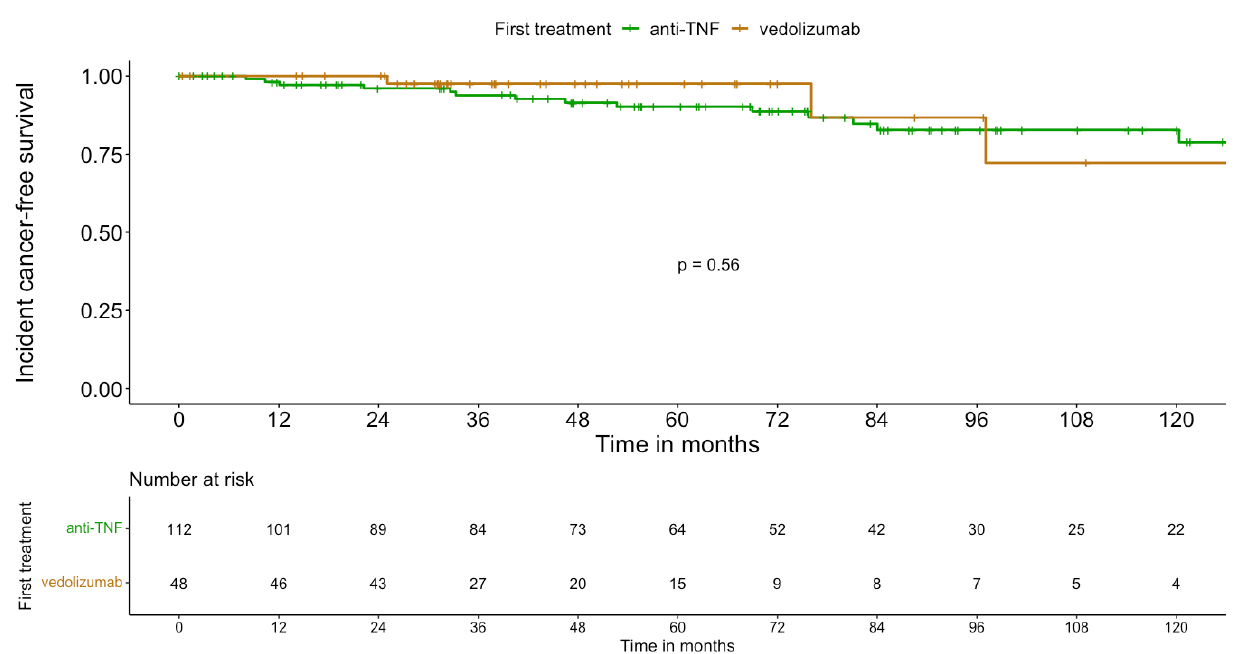
Figure 3. Incident-cancer-free survival with anti-TNF and vedolizumab in IBD patients with